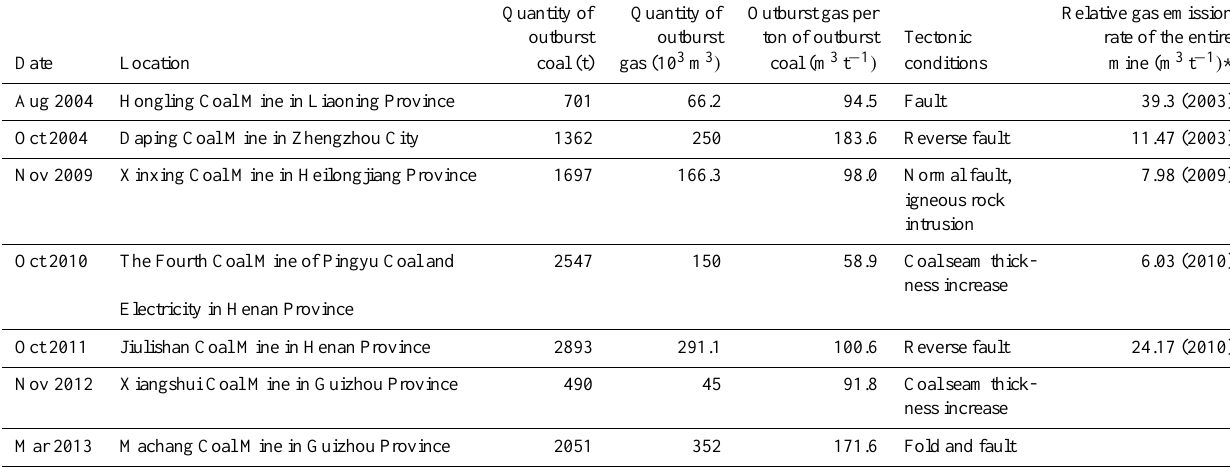
Table 1. Recent large-scale outbursts in coal mines in China.